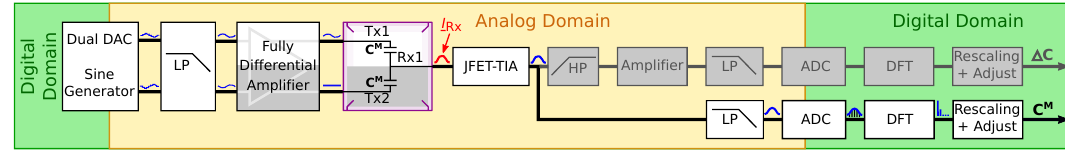
Figure 8: Measurement concept for the absolute capacitance measurement of C M . The differential path in gray is disabled while reusing some of its component for the absolute capacitance